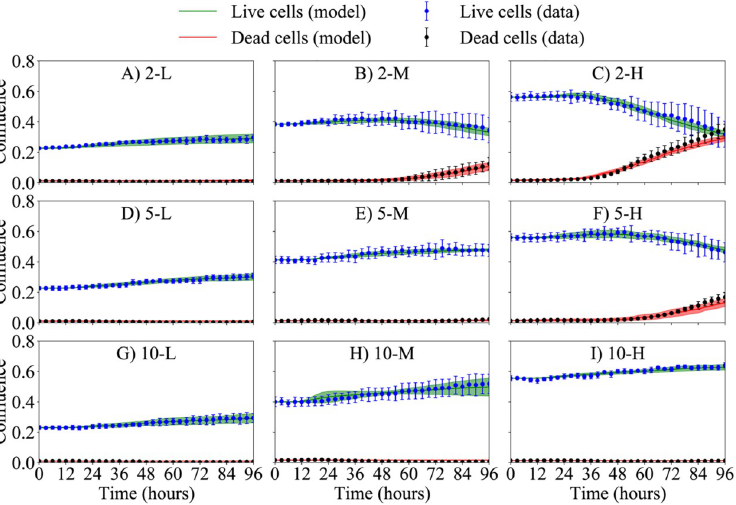
Fig 8. Calibration of scenarios with 2, 5, and 10 mM initial glucose concentration. Scenario-specific calibration of the cgABM to the time-resolved microscopy data for scenarios 2-L (panel A), 2-M (panel B), 2-H (panel C), 5-L (panel D), 5-M (panel E), 5-H (panel F), 10-L (panel G), 10-M (panel H), and 10-H (panel I). The data mean and 95% credible interval for the live and dead cells are shown in blue and black, respectively. The mean of the simulation is represented as a solid line, and the area is the 95% credible interval for the live (green) and dead (red) cells. The low initial confluence in scenario 2-L assures that the initial glucose concentration can sustain tumor growth during the 96 hours. The high initial confluence in scenario 5-H is the only one in the experiments with 5 mM initial glucose concentration for which the initial glucose concentration cannot sustain tumor growth during the 96 hours, leading to an increase in the dead cell confluence. The 10 mM glucose condition is sufficient to sustain tumor growth during the 96 hours for all seeding density